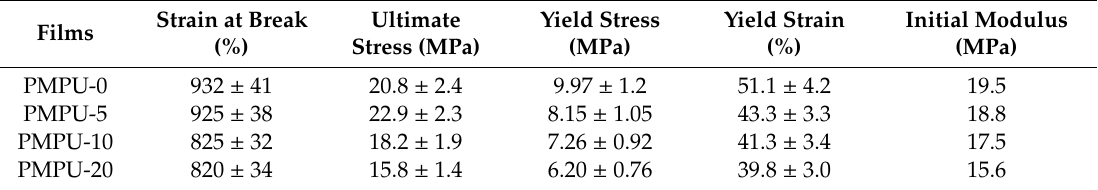
Figure 2. Stress–strain behaviors of PMPU films with varying PMEH content. Table 2. Tensile properties of PMPU films with varying PMEH content.